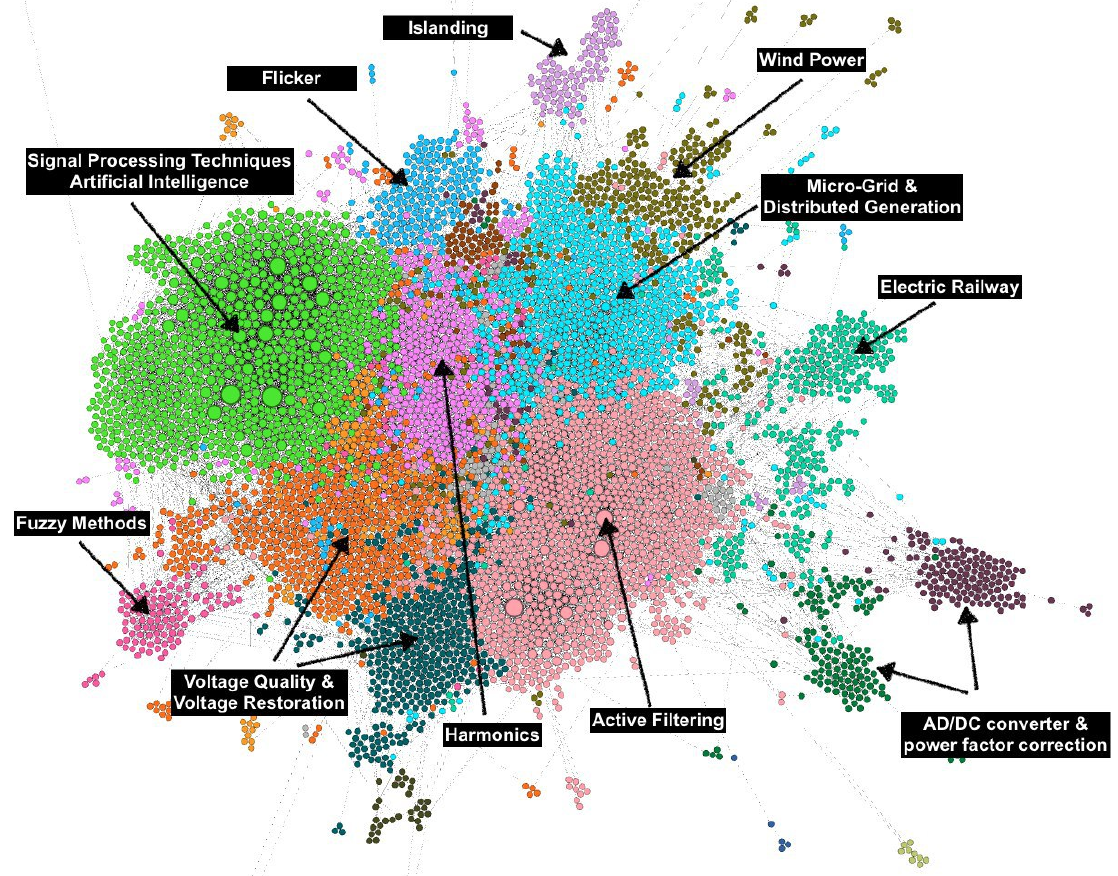
Figure 2. Research topics related to power